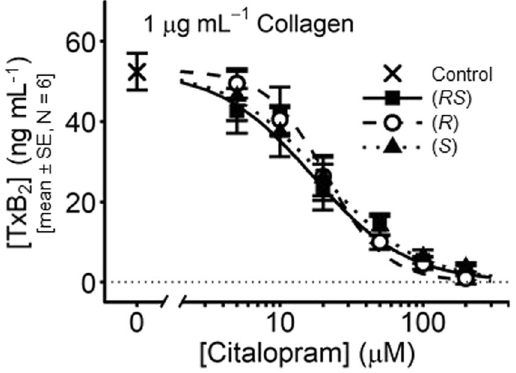
Figure 3. Inhibition by citalopram of TxB 2 generation. Platelets were stimulated with collagen (1 µ g mL − 1 ) for 6 min under aggregometry conditions (37 °C, 1,000 rpm) and supernatants isolated. Full concentration- inhibition curves were obtained for ( RS )-, ( R )- and ( S )-citalopram (0–200 µ M). 2-way ANOVA was performed with IBM SPSS v.23: (Effect 1 (fixed) = citalopram {( RS ), ( R ), ( S )}; Effect 2 (random) = donor {N = 6}). The results indicated no difference in the pIC 50 of the three citalopram preparations ( P = 0.60, F = 0.54, df = 2, 10.